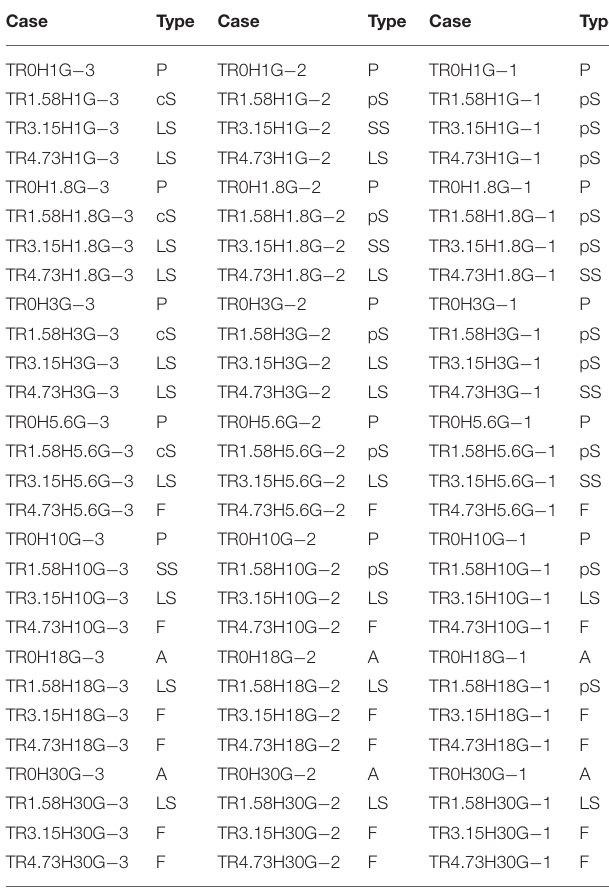
TABLE 2 | Cases and results of numerical simulations without time change in v tr